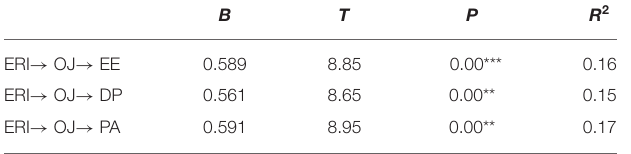
TABLE 4 | Summary of indirect effects.